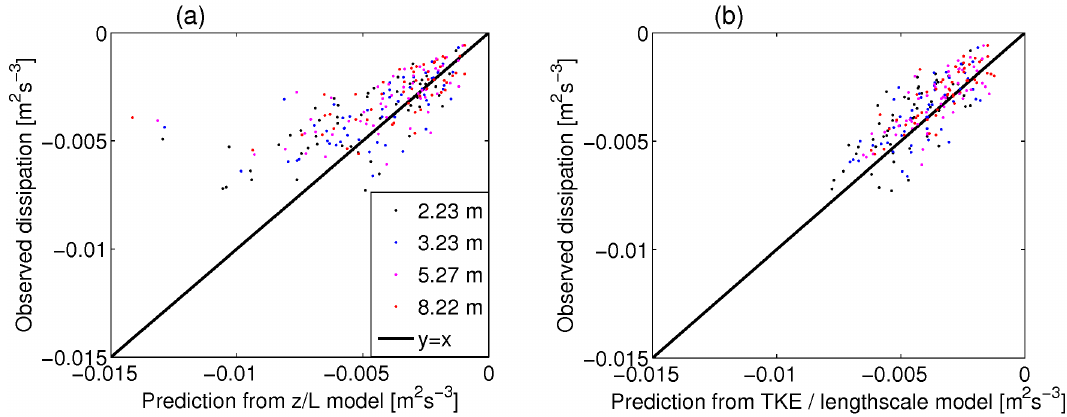
Figure 12. Comparison between observed and predicted dissipation is shown for a model based on z/L in panel (a) and based on TKE and a dissipation length scale taking into account measurement height and boundary layer depth in panel (b) . Data shown as black, blue, magenta and red dots denote 2.23, 3.23, 5.27 and 8.22m measurement height,